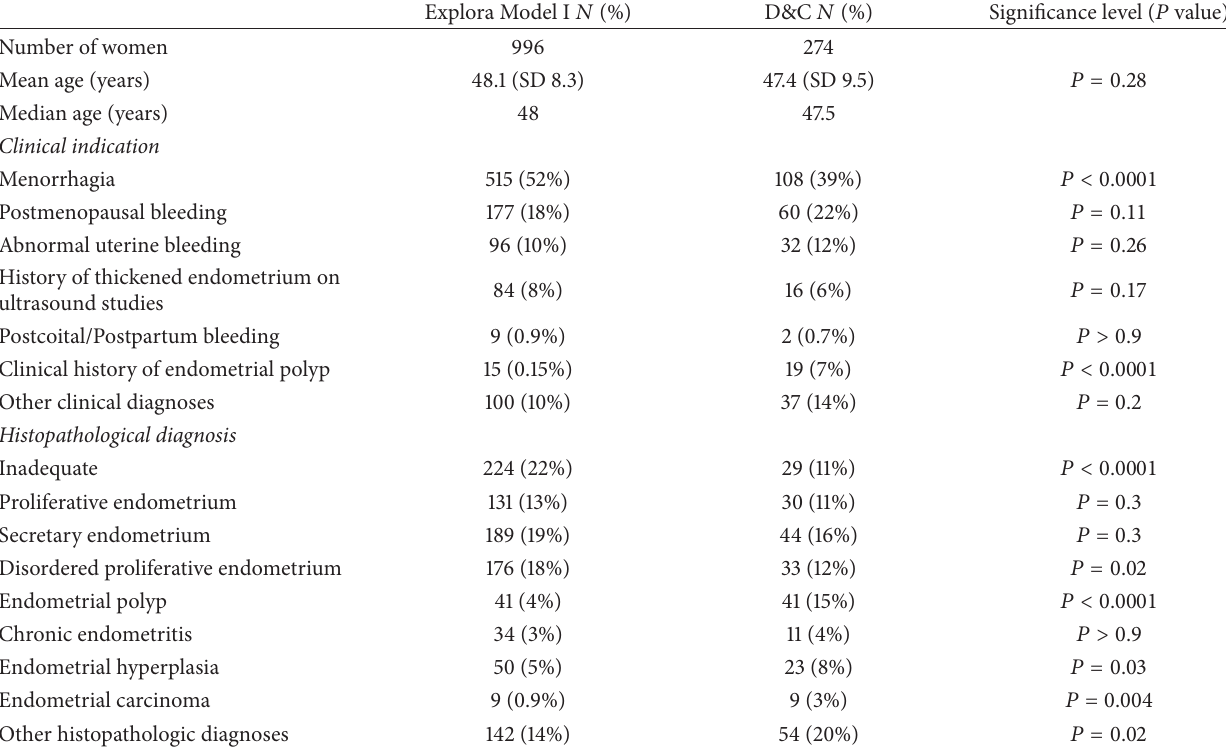
Table 1: Characteristics of patients on whom both Explora and D&C methods were